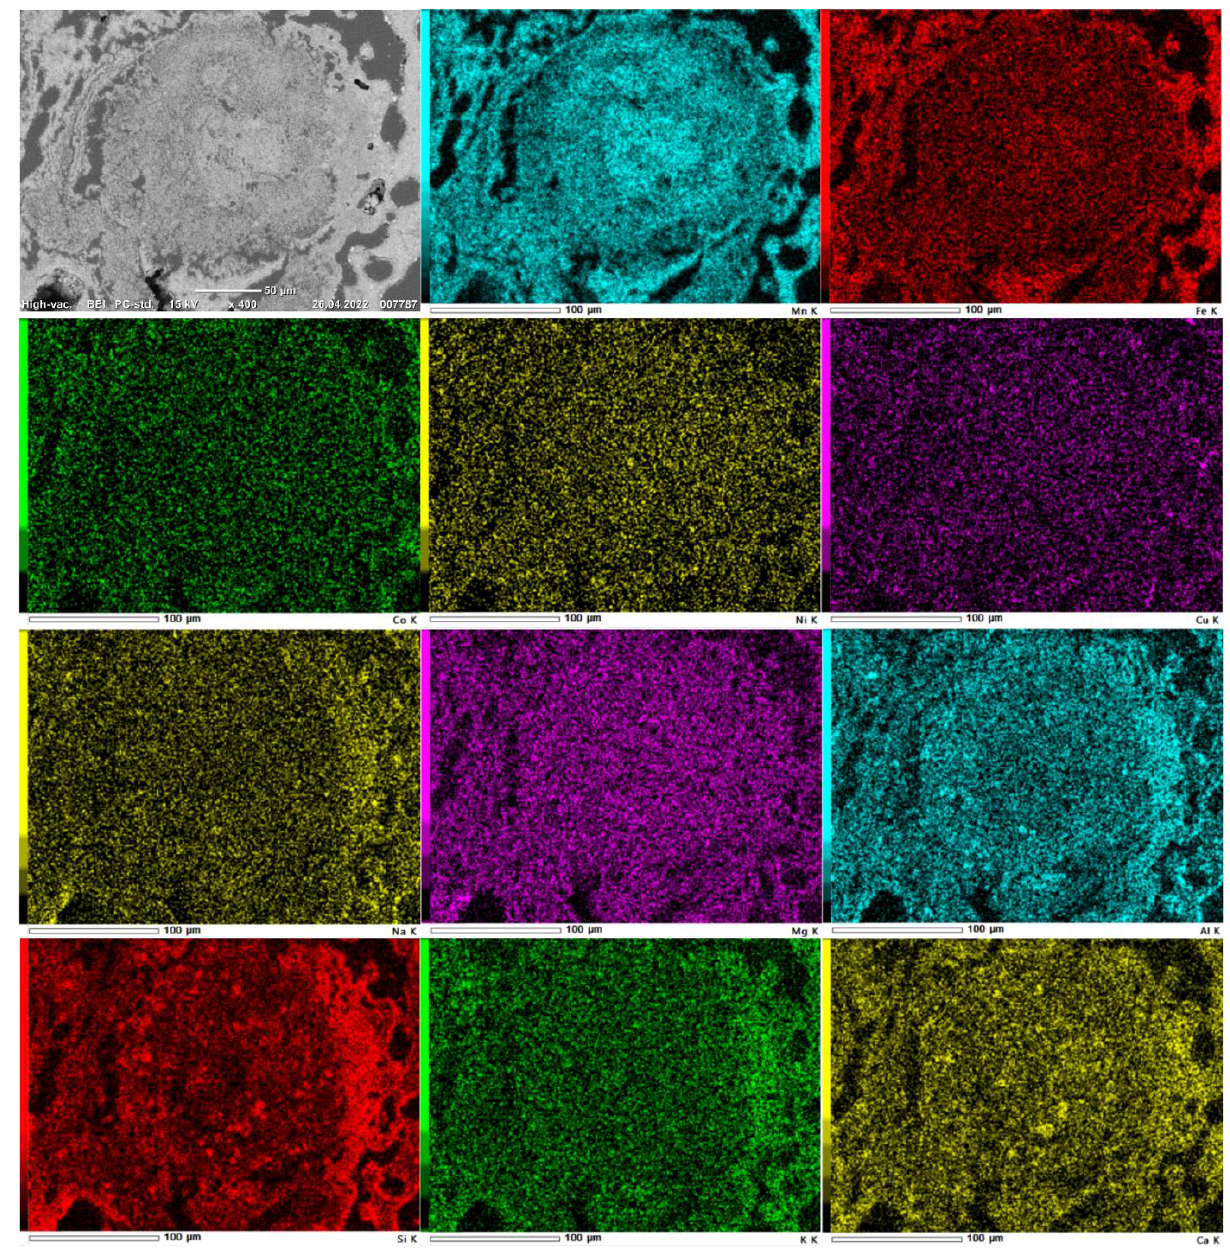
Figure 10. SEM-BEI image of a reduced PMMN and EDS elemental distribution mapping of the same area.